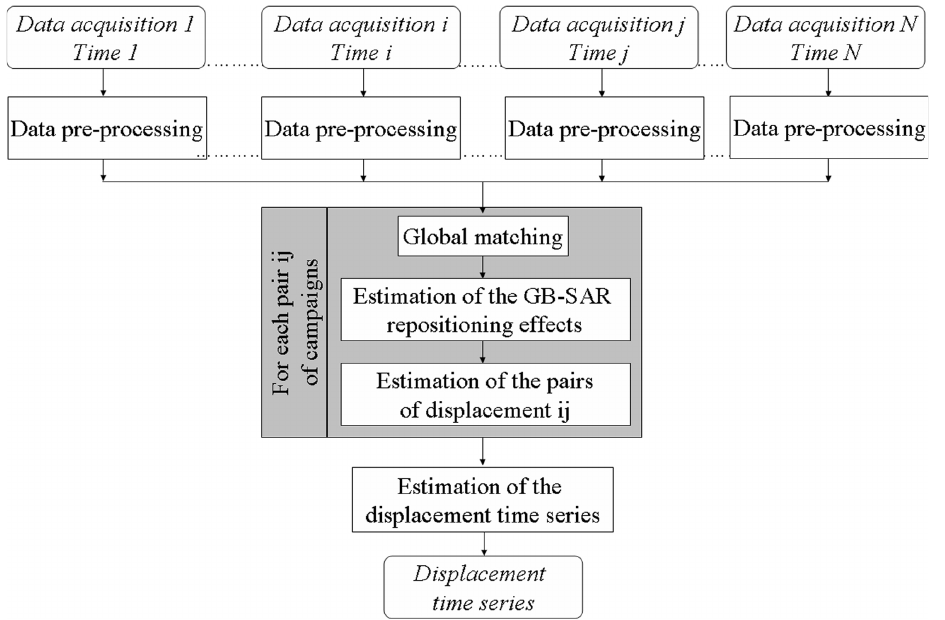
Fig. 2. Diagram of the GB-SAR non-interferometric